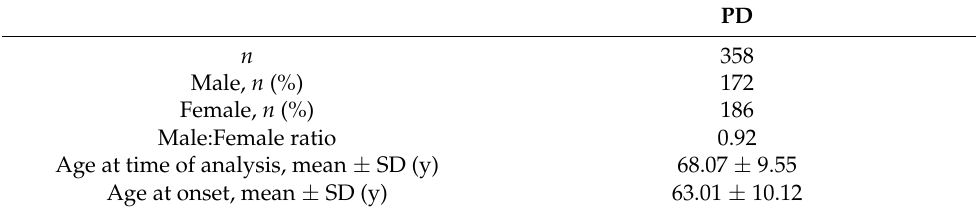
Table 1. Demographic and Clinical Characteristics of PD